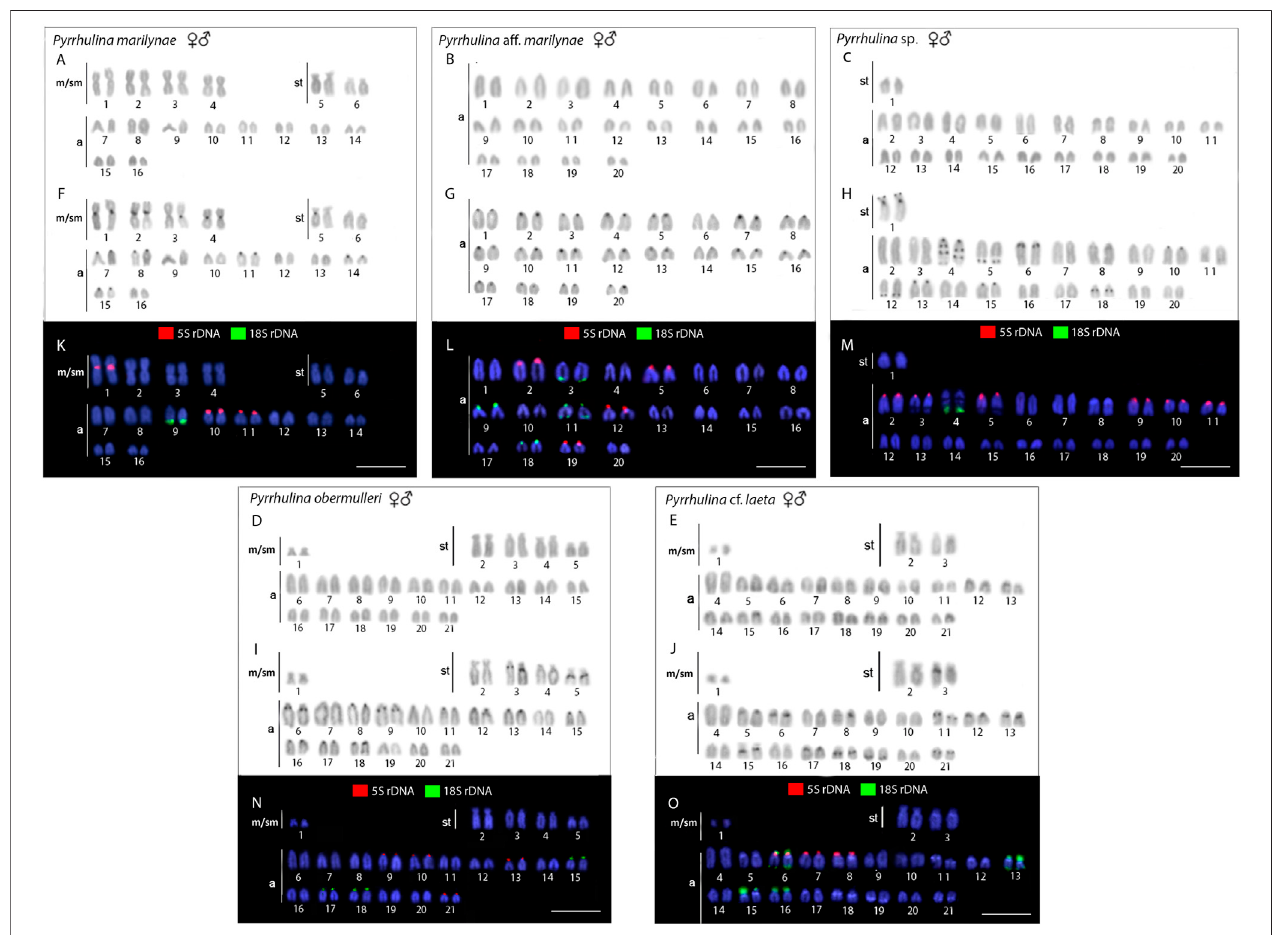
FIGURE2| Maleandfemalekaryotypesof Pyrrhulinamarilynae (A,F,andK) , Pyrrhulina aff. marilynae (B,GandL) , Pyrrhulina sp. (C,HandM) , P.obermulleri (D, I and N) and Pyrrhulina cf. laeta (E, J and O) arranged after Giemsa staining (A-E) , C-banding (F-J) , and dual-color in situ hybridization (FISH) with 18S (green) and 5S (red) ribosomal DNA probes (K-O) . Chromosomes were counterstained with 4 ′ ,6-diamidino-2-phenylindole (DAPI).Scale bar (cid:1) 5 μ